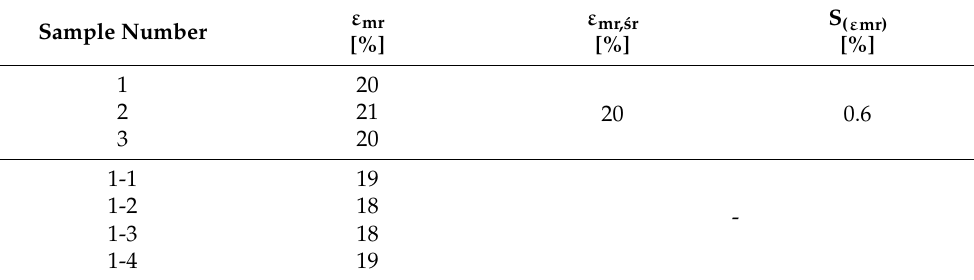
Table 9. Results of determination of strain at compression ε mr